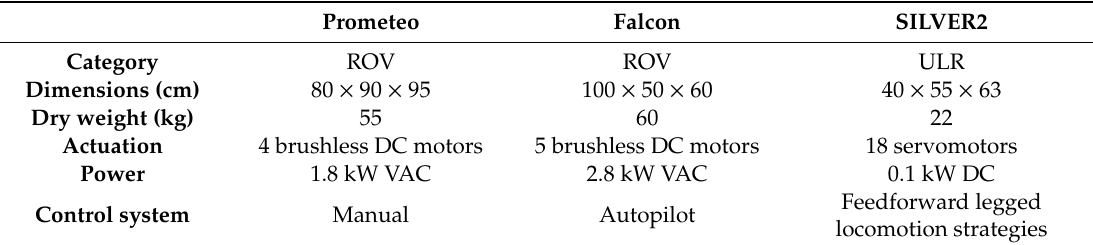
Table 1. Overview of relevant information of the robots used in this